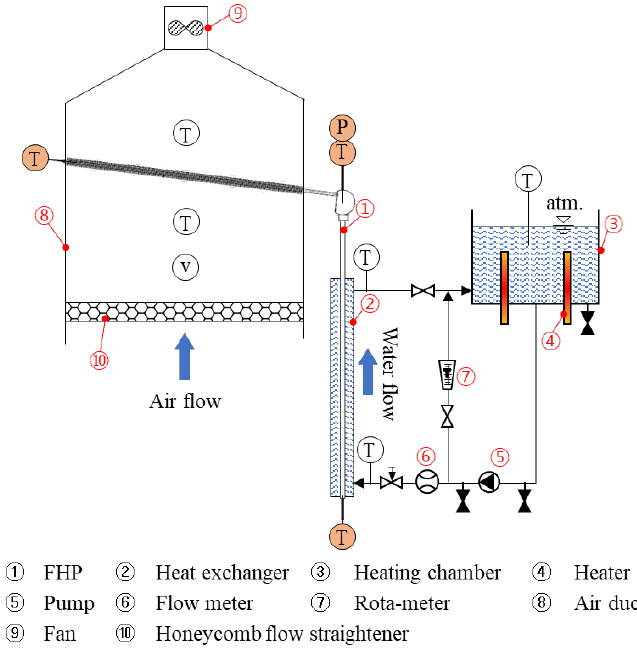
Figure 5. Schematic diagram of the FHP heat transfer test apparatus. Table 1. Specifications of the major devices in the test apparatus.